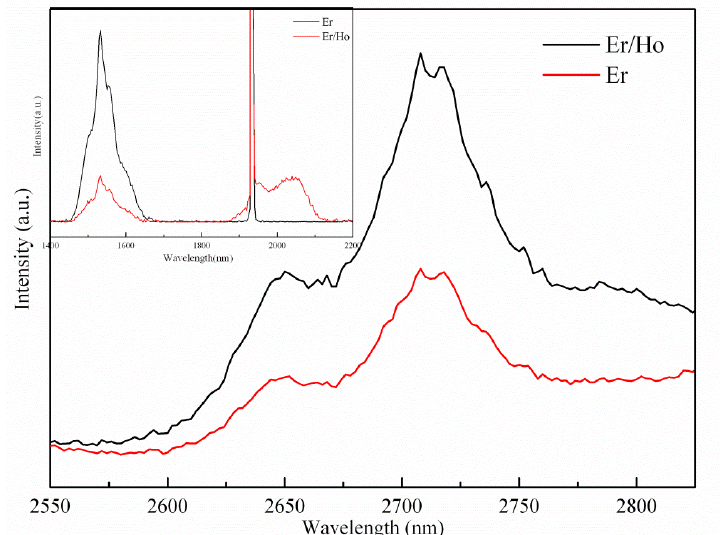
Figure 2. Near-infrared and Mid-infrared fluorescence spectra of Er 3+ and Er 3+ /Ho 3+ - codoped fluorotellurite